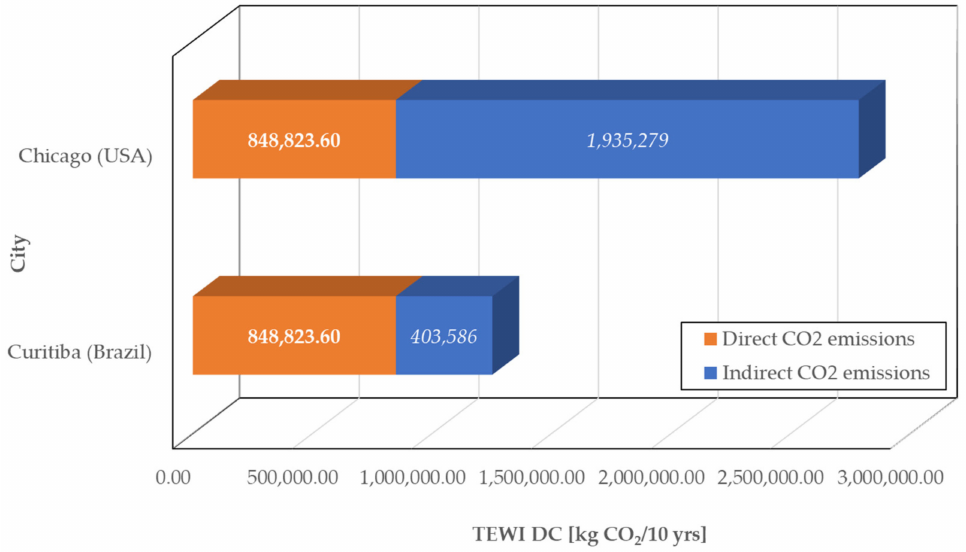
Figure 2. Comparison of TEWI DC (direct and indirect CO 2 emissions) of a DC installed in Chicago and